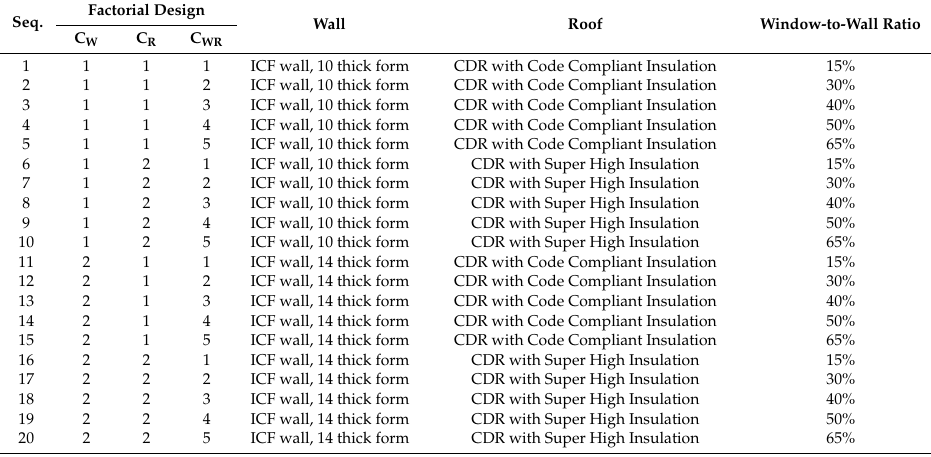
Table 3. Experimental design